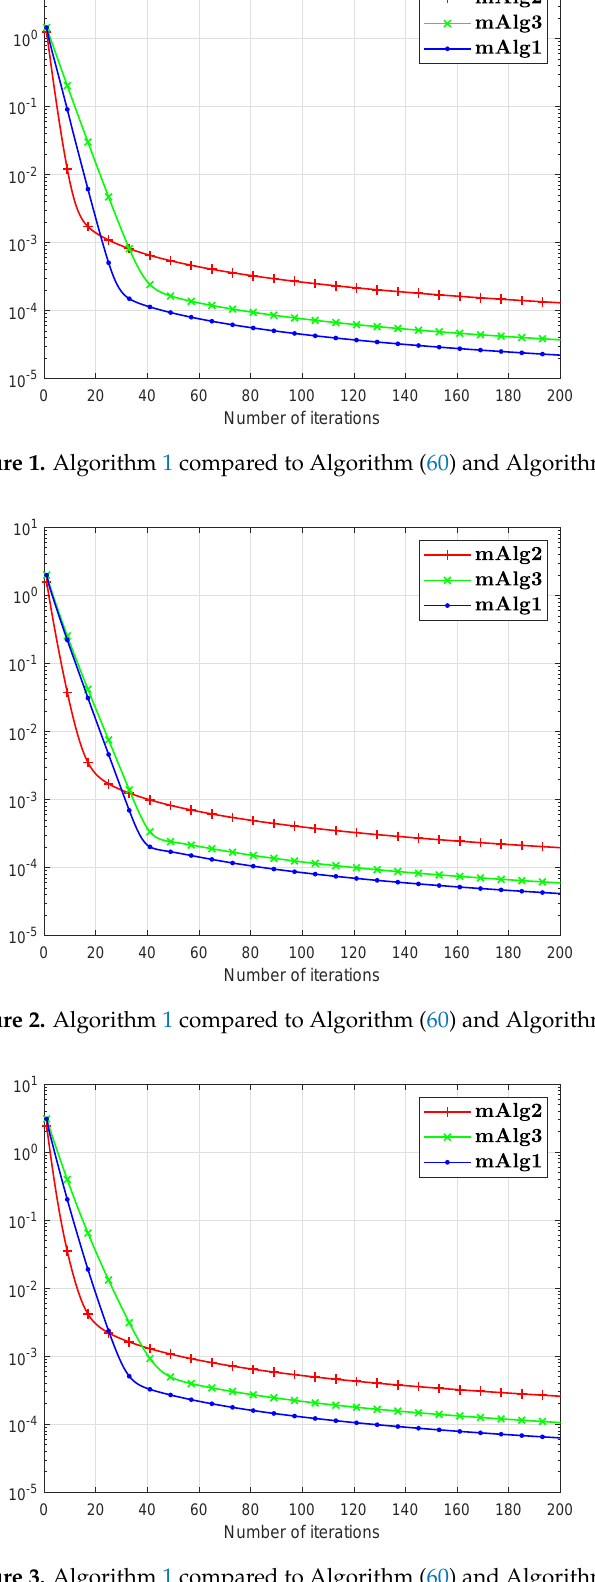
Figure 3. Algorithm 1 compared to Algorithm (60) and Algorithm 3.2 in [34] for R 20